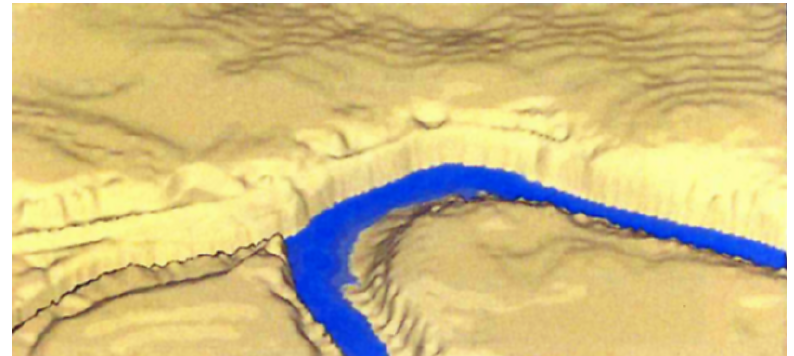
Figure 10. River level at the second measurement campaign ( t =